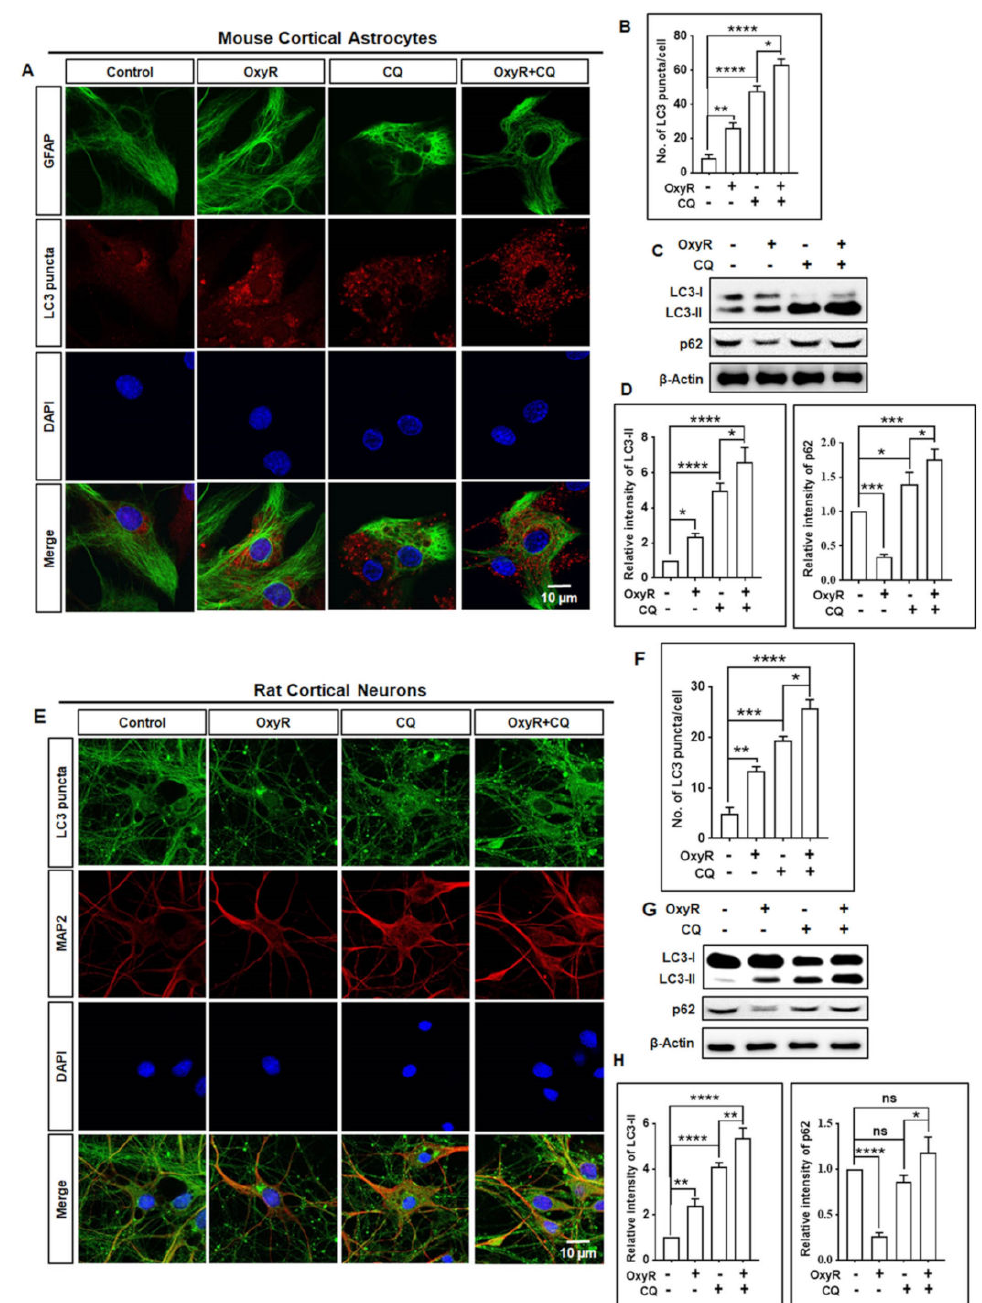
Figure 1. OxyR treatment induced autophagic flux in cortical astrocytes and neurons. ( A , E ) Before harvest, cells were treated with 10 µ M CQ for 2 h. Images were acquired using a confocal microscope. ( B , F ) Numbers of LC3 puncta were counted and analyzed using one-way ANOVA ( n = 3). ( C , G ) Before harvest, CQ treatment for 2 h was performed and representative LC3 and p62 levels were determined by Western blotting. ( D , H ) Statistically significant differences were determined by one-way ANOVA ( n = 3). Data are presented as mean ± SEM. * p < 0.05, ** p < 0.01, *** p < 0.001, **** p < 0.0001, ns: non-significant. OxyR, oxyresveratrol; CQ, chloroquine; GFAP, glial fibrillary acidic protein; LC3, microtubule-associated protein light chain 3; DAPI, the nuclear marker 4 (cid:48) ,6-